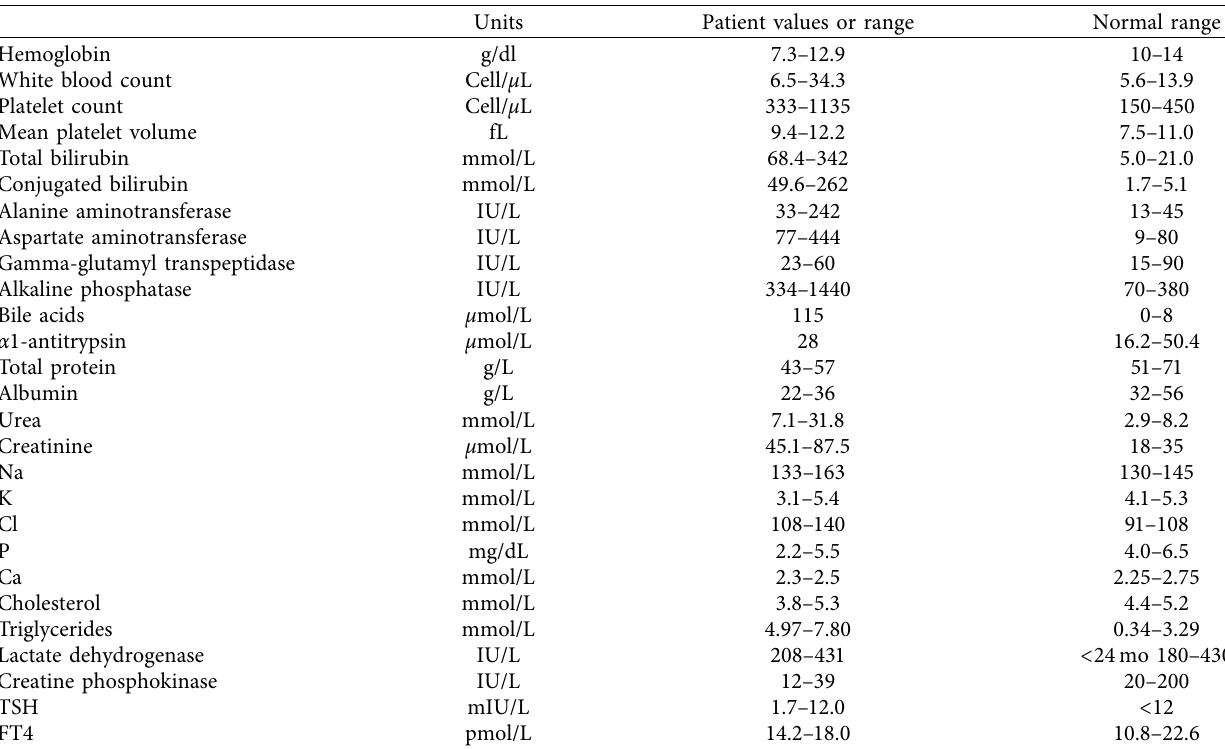
Table 2: Blood/serum laboratory